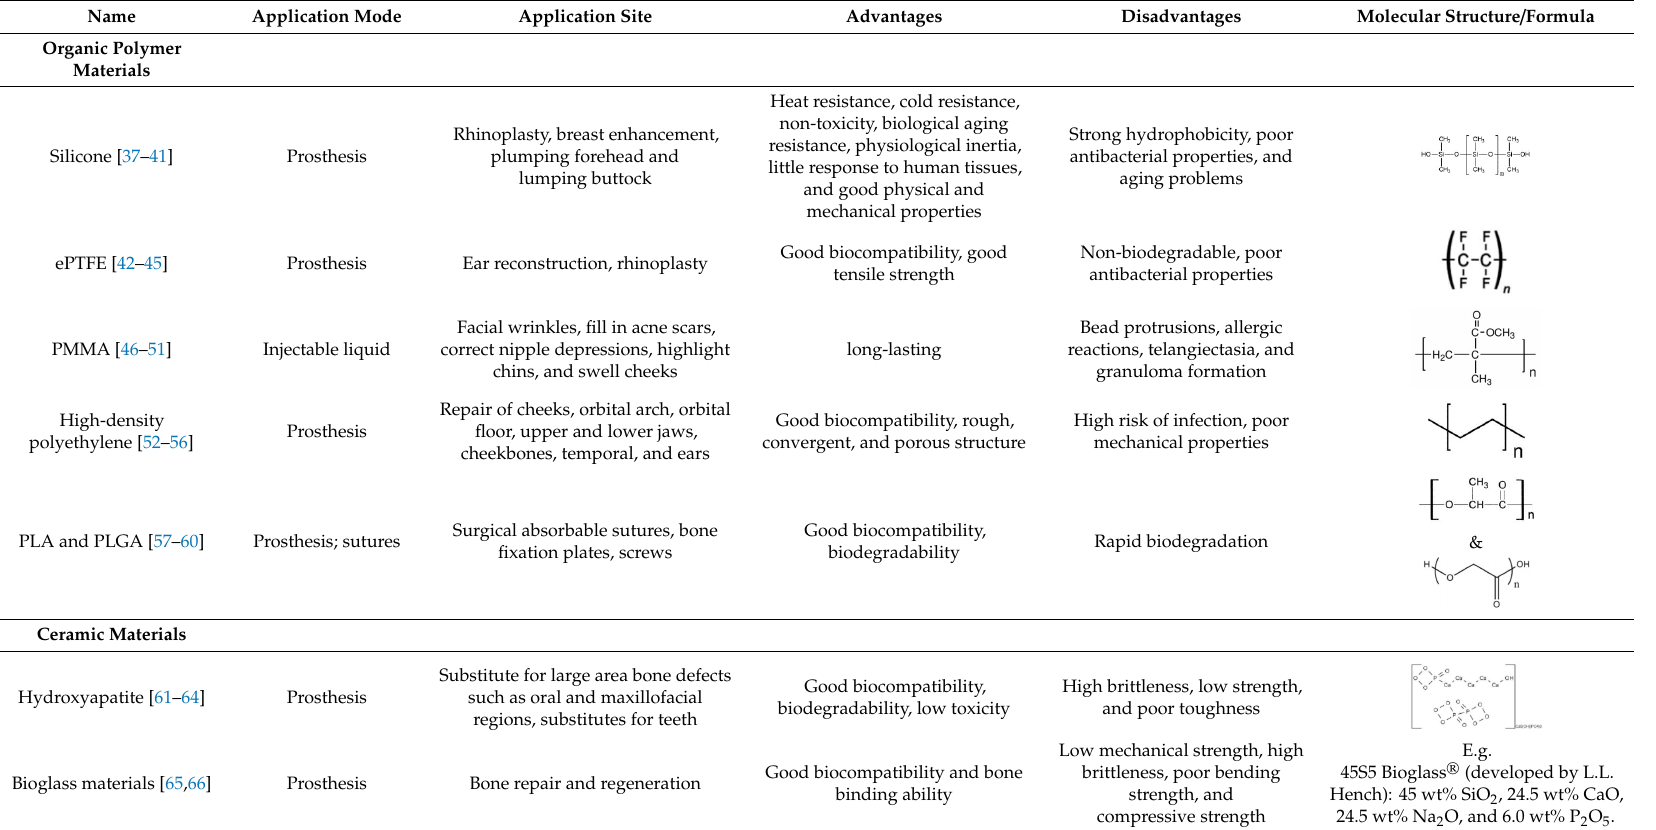
Table 2. Overview of synthetic polymers related to plastic surgery.